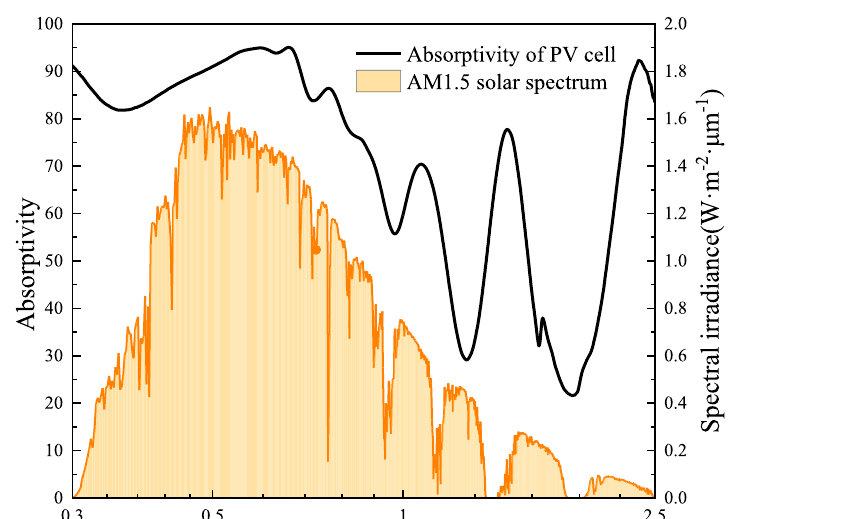
Fig. 2 Photo and schematic of the ( a ) A-PV/T and ( b ) T-PV/T